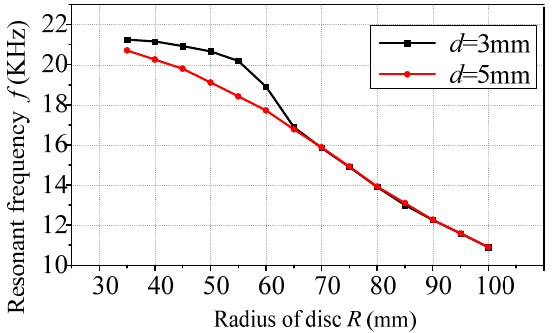
Figure 7. Variation of resonant frequency with the disc’s radius.